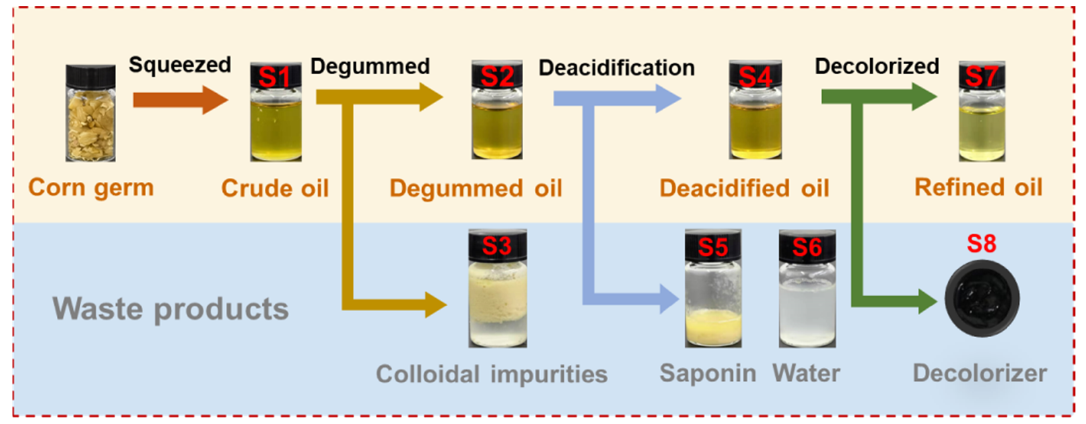
Figure 1. The flow diagram of simulating the maize germ oil refining process in the laboratory.